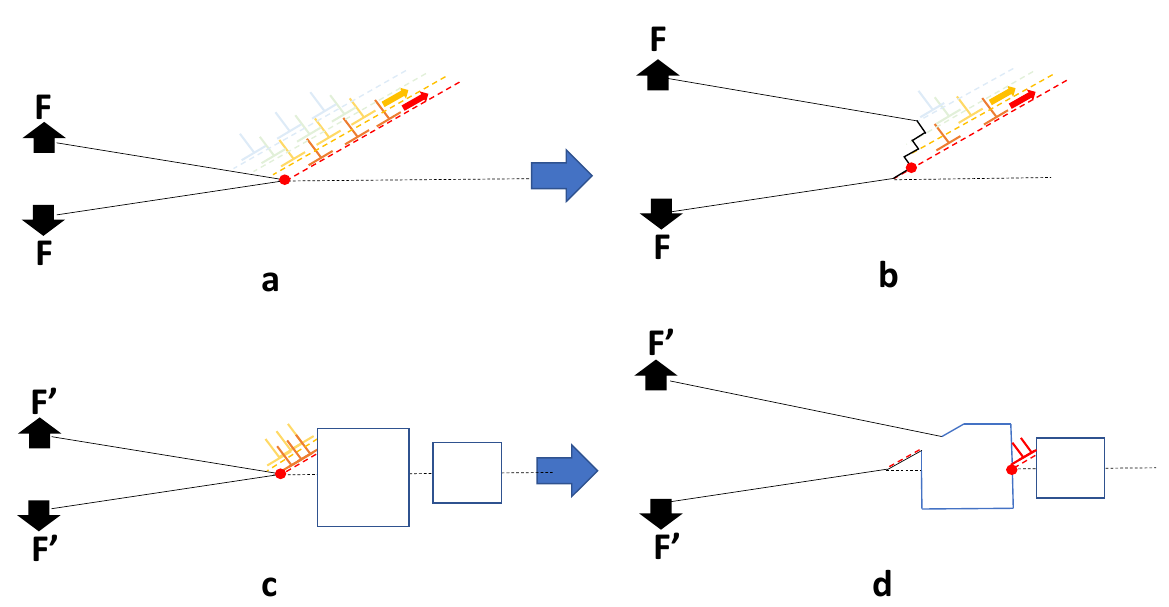
Figure 17. Schematic diagram showing the effect of cavities in restricting the volume for dislocation translation, thus limiting the absorbed energy for crack advance (lowering fracture toughness). The stress at the hinge points (red dots) will be dependent on the area of the ligament up to the nearest free surface (cavity): ( a ) crack on a boundary/interface subject to a crack-opening load (F); ( b ) crack blunting and energy absorption due to dislocation emission; ( c ) restricted dislocation emission (lower energy absorption for crack advance) and lower applied force (F’) needed to activate slip in the presence of cavities; ( d ) hinge point shift to next ligament.